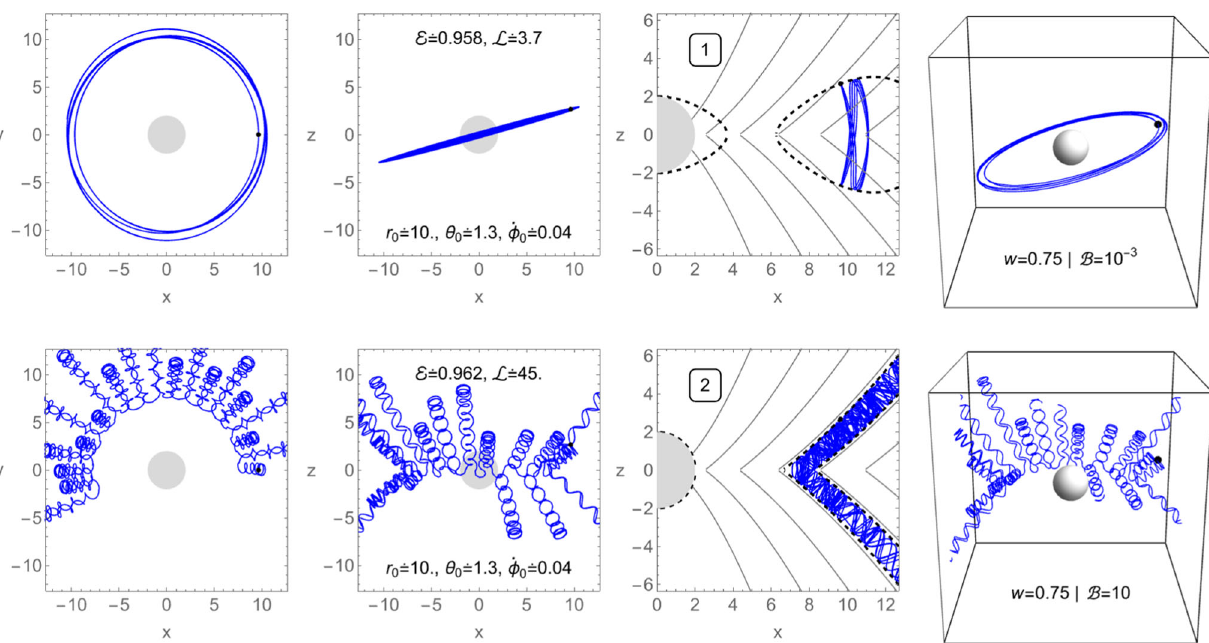
Fig. 6 Charged particles trajectories (blue) around BH with parabolic MF, representing two astrophysically relevant cases: when MF influ- ence is negligible ( | B |(cid:12) 1, first row), and when LF is dominating over